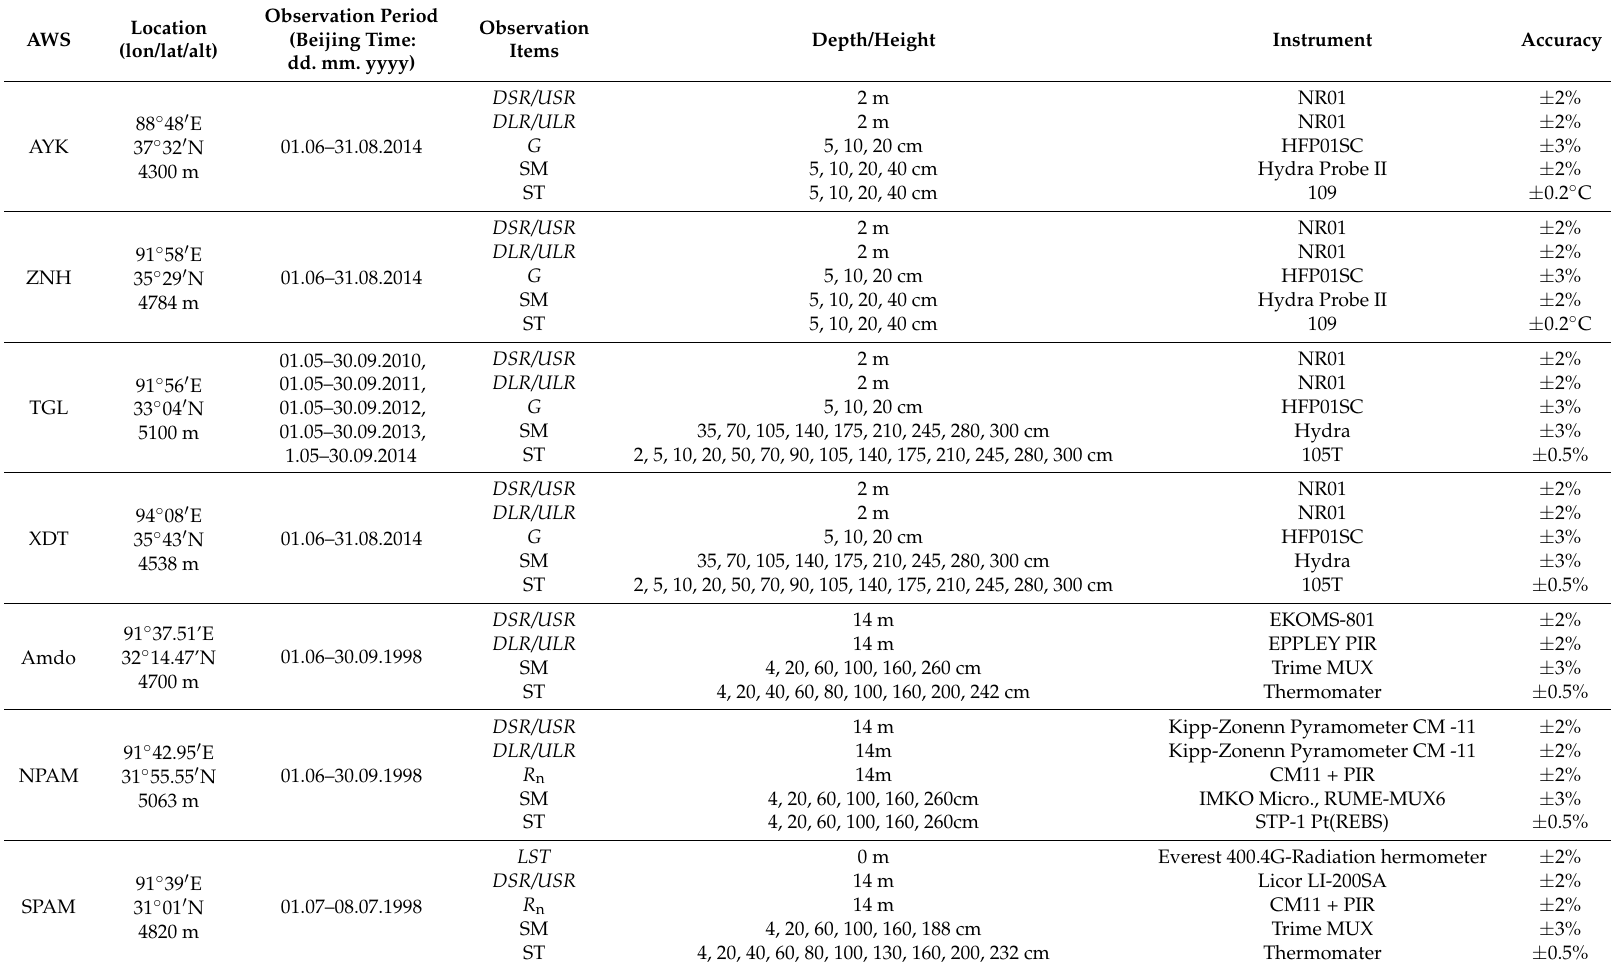
Table 1. Observation instruments and observation